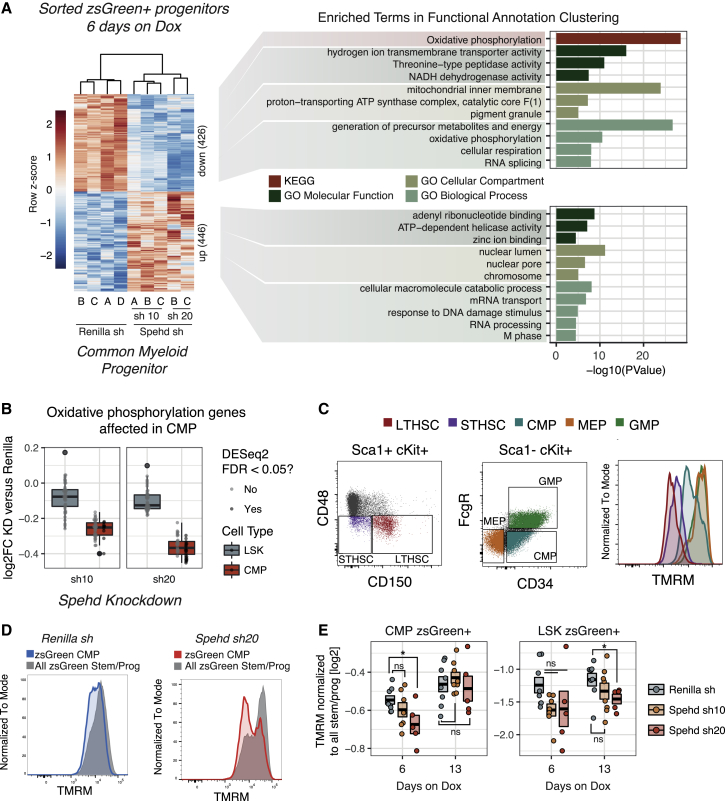
Depletion of lnc12928 Results in Deficient Mitochondrial Function in Myeloid Progenitors(A) Heatmap of all of the differentially expressed genes (FDR < 0.05, DESeq) between Spehd and Renilla knockdown in CMP (left) and the results of functional annotation analysis (right).(B) Fold change for each shRNA against the lncRNA relative to Renilla in CMP and LSK for the genes in the oxidative phosphorylation pathway (KEGG) differentially expressed in CMP. Box and whiskers plots show the distribution of all of the genes represented. Boxplots correspond to the median and the 25th and 75th percentiles. The whiskers extend to the largest values, but no further than 1.5, the interquartile range (distance between the first and third quartiles), in which case the outliers are shown.(C) Representative flow cytometry plots showing the gating strategy for long-term (LT) and short-term (ST) repopulating HSCs (out of Lin− Sca1+ cKit+) and CMPs, GMPs, and MEPs (out of Lin− Sca1− cKit+), and the corresponding distribution of the TMRM intensity for each population.(D) Representative flow cytometry plots of the TMRM of CMP and the TMRM in all of the progenitors and stem cells for Renilla shRNA and shRNA 20 against lnc12928.(E) TMRM (geometric mean) in CMP or LSK relative to overall TMRM in the sample (in all of the progenitors and stem cells) per animal. The box represents average and SEM. ∗p < 0.05; Mann-Whitney test.See also Figure S4.